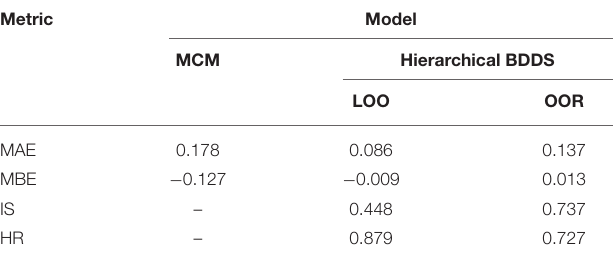
TABLE 2 | Performance of MCM and hierarchical BDDS models. Metric